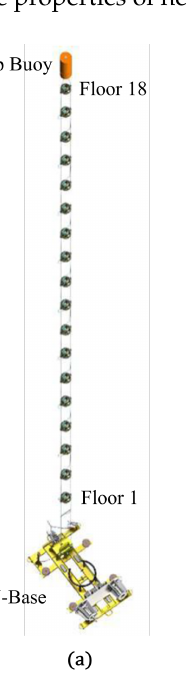
Figure 1. ( a ) Scheme of the detection unit in the KM3NeT detector. It is composed of a detection unit (DU)-base fixed to the anchor with a hydrophone installed among other instruments, 18 Digital Optical Modules (DOMs) (labeled Floor 1, ..., Floor 18), and the top buoy. ( b ) Encapsulated piezoceramic and electronic board with a pre-amplifier. It is the acoustic receiver installed at the bottom of each DOM. ( c ) Three autonomous Acoustic Beacons before their deployment at the Astroparticle Research with Cosmics in the Abyss (ARCA) site. ( d ) Hydrophone installed on the DU-bases of KM3NeT.